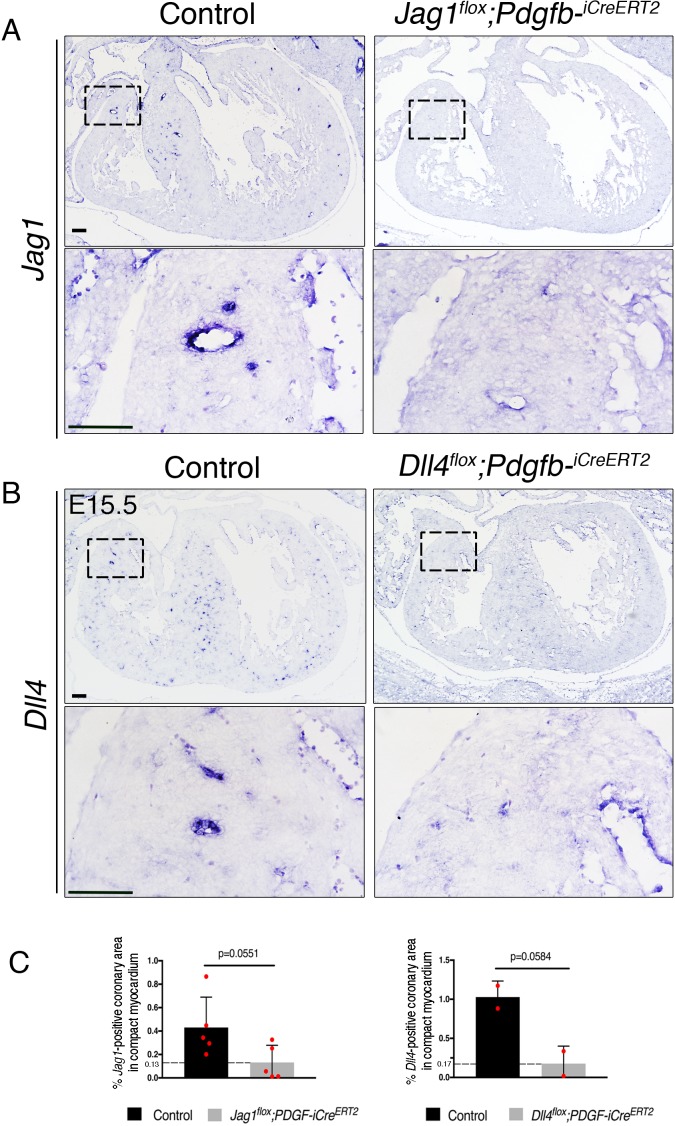
Efficient tamoxifen-induced endothelial deletion of Jag1 and Dll4 using Pdgfb-iCreERT2 driver line.(A) ISH of Jag1 on sections of E15.5 control and Jag1flox;Pdgfb-iCreERT2 embryo hearts tamoxifen-induced at E12.5. (B) ISH of Dll4 on sections of E15.5 control and Dll4flox;Pdgfb-iCreERT2 hearts tamoxifen-induced at E14.4. (C) Quantified data of ISH staining as percentage of Dll4- or Jag1-positive coronary artery area in compact myocardium of E15.5 control, Jag1flox;Pdgfb-iCreERT2 and Dll4flox;Pdgfb-iCreERT2 tamoxifen-induced at E12.5 and E14.5, respectively. A Student’s t test was applied. n = 2 for control and Dll4flox;Pdgfb-iCreERT2 hearts, and n = 5 for control and Jag1flox;Pdgfb-iCreERT2 hearts. Scale bar, 100 μm.